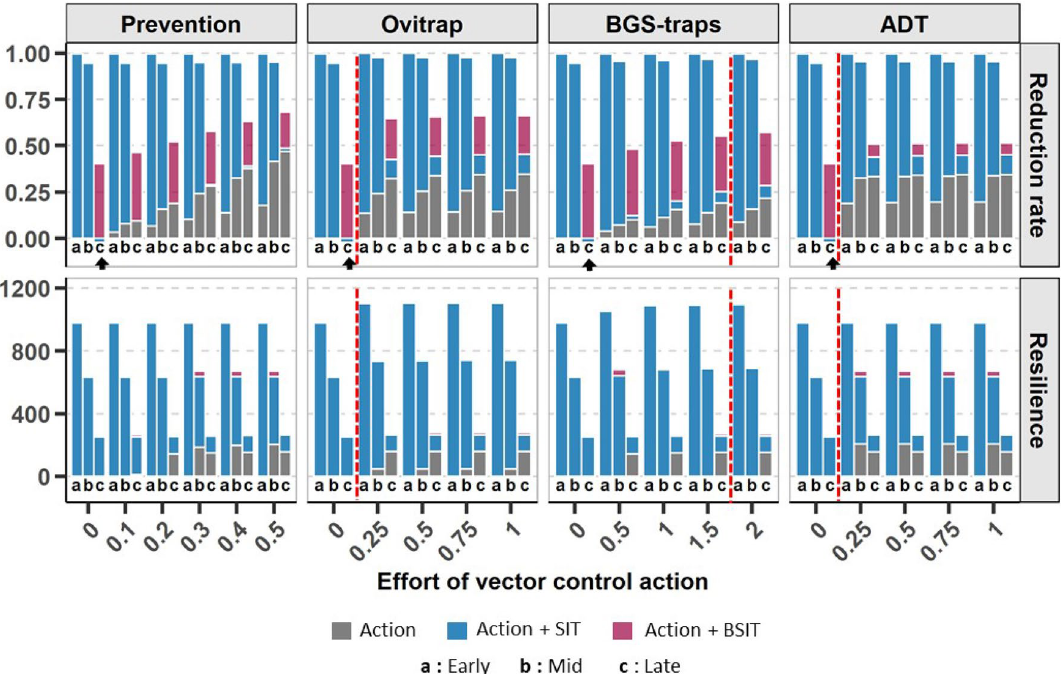
Figure 3. Reduction rate and resilience in the temperate climate for an increasing effort in vector control actions against Aedes albopictus . Vector control actions (ovitraps, BGS-traps, ADT and prevention) are represented by grey bars. The benefits added by combining them with (1) SIT (releases of 1000 males/ha) and (2) BSIT (releases of 1000 males/ha) are represented by pink and blue bars, respectively. The effort devoted to each control action is indicated, either as a rate of breeding sites destroyed for prevention, or as the number of traps/stations per house for ovitraps, BGS-traps and ADT. Three control periods were tested: early in the year (Early) when the mosquito population is low, midway in the year (Mid) when the population is increasing, and later in the year (Late) when the population reaches its maximum. The vector control actions were simulated on a mean weather dynamic and outputs were averaged among the 4 studied parcels (see “Methods”). The red dashed line indicates the number of ovitraps, BGS-traps and ADT stations required to reach the plateau of maximum effect for the action performed alone. The black arrows show the very specific case of the negative reduction rate alone caused by late releases of SIT without any other vector control